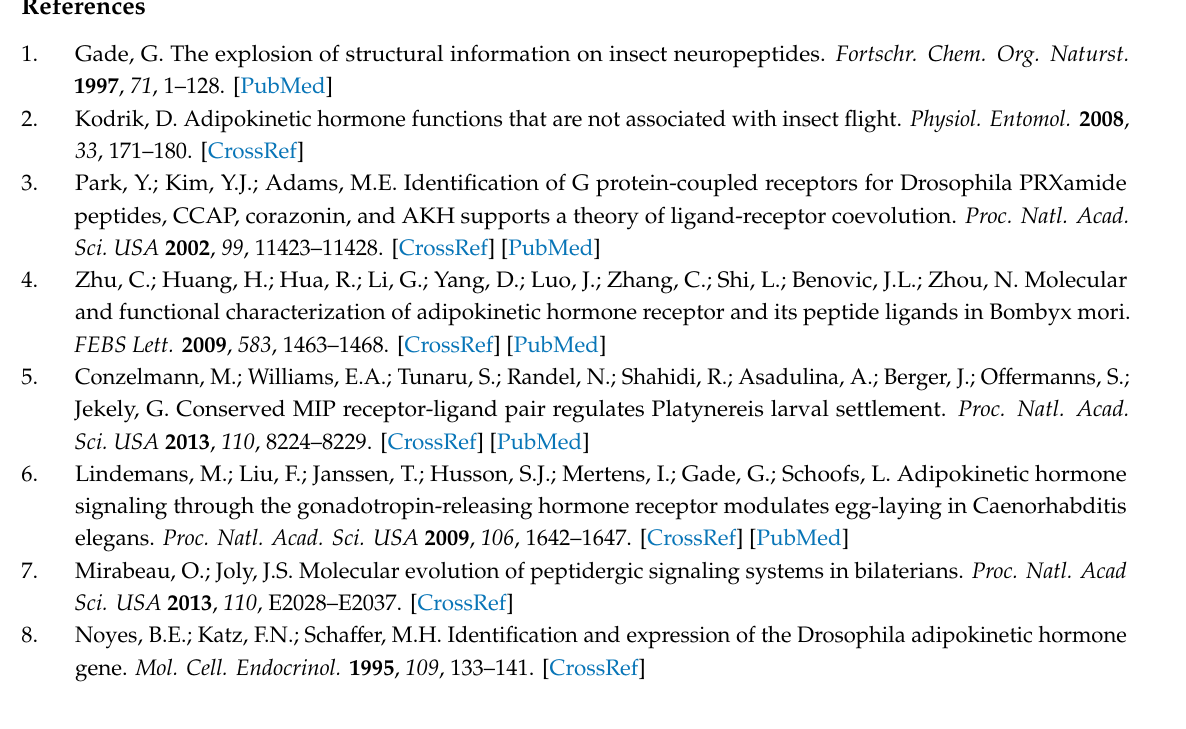
Figure S1: Level of free carbohydrates in silkworm larval hemolymph of fourth and fifth instars. Table S1: Contingency tables comparing observed and expected results (proportion of mutants). Table S2: Primer list for